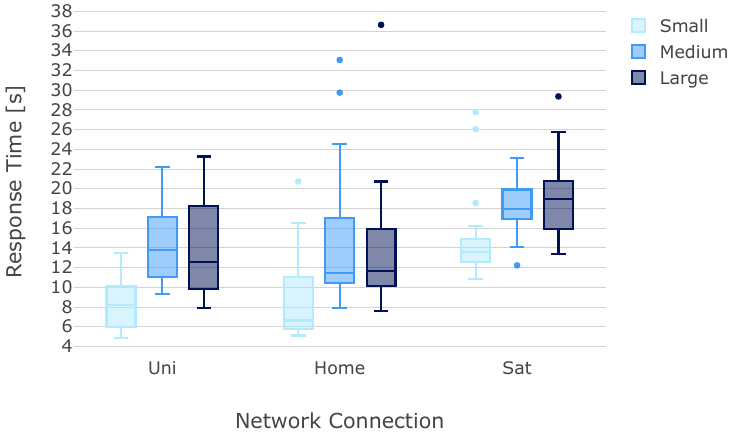
Figure 16. Response time using the UNI, HOME and SAT network connections, in case of a pre- loaded video on Google Cloud Service server, with different size (small, medium and